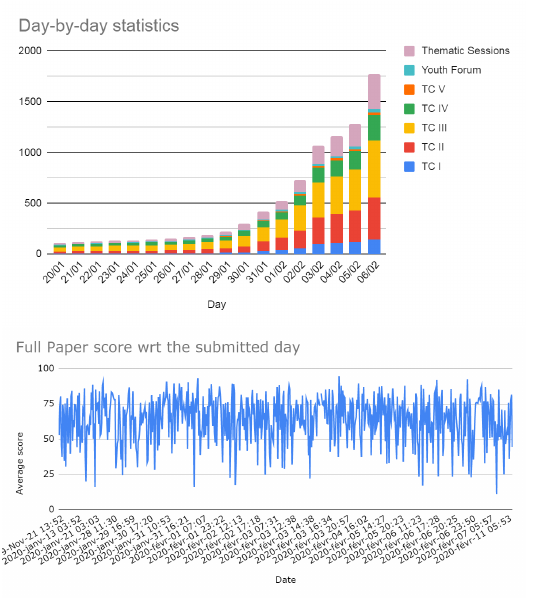
Figure 4. Day-by-day statistics for the submitted